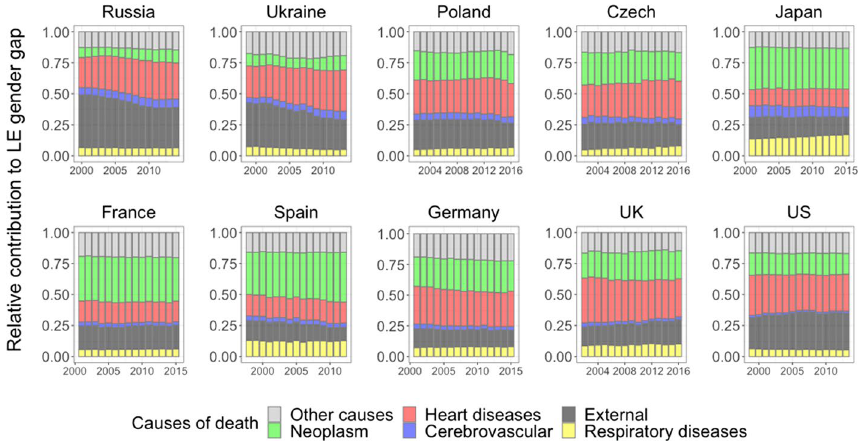
Fig. 3 Relative contribution of causes of death to sex gap in life expectancy in each